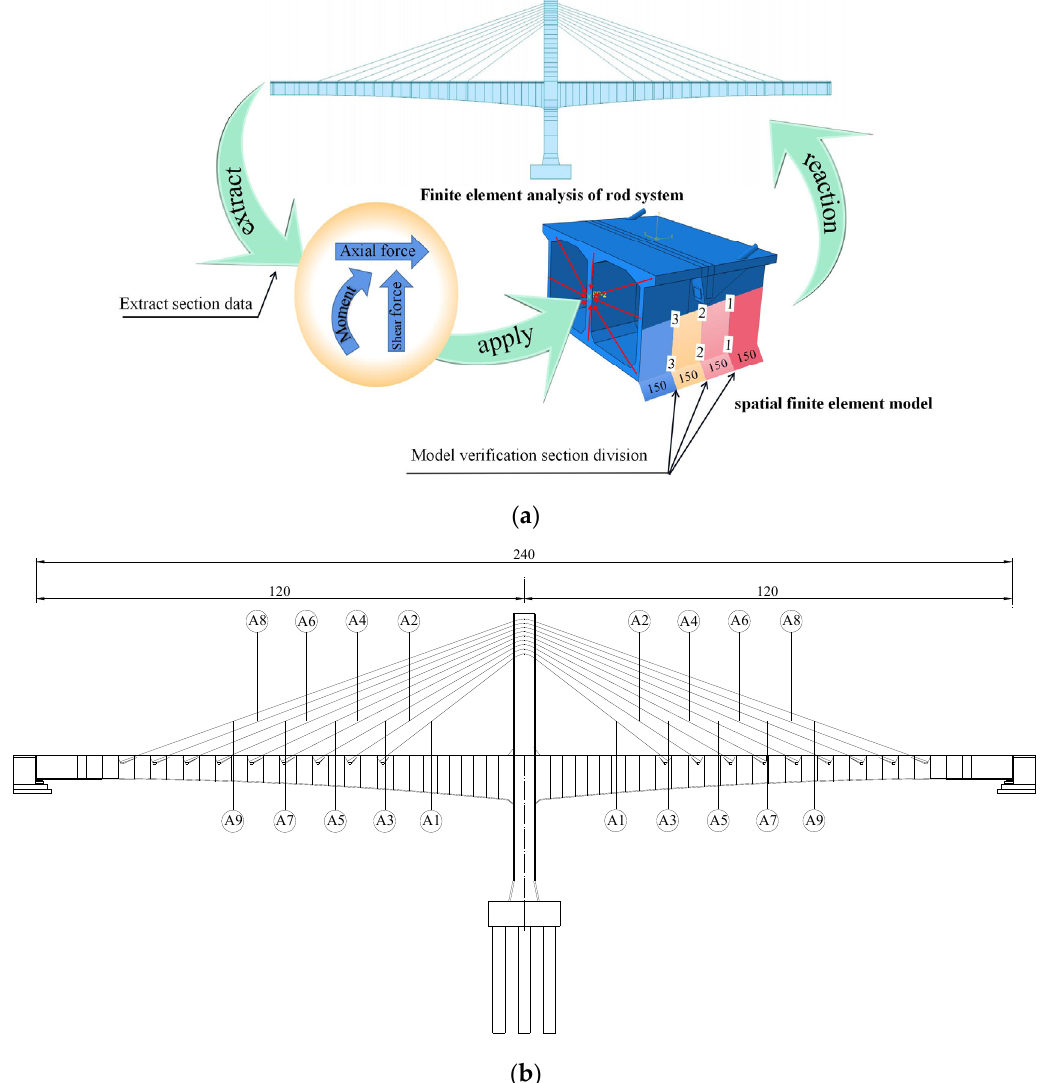
Figure 10. Bridge elevation information and loading mode. ( a ) Boundary condition diagram; ( b ) the elevation layout of the bridge (unit: m).